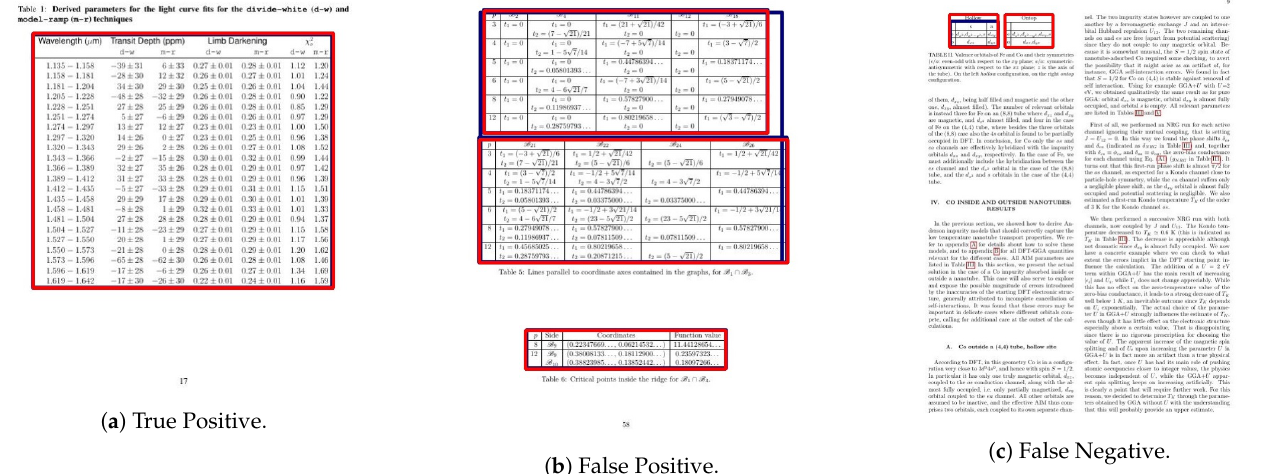
Figure 6. HybridTabNet results on TableBank Latex dataset. ( a – c ) True positive, False positive, and False negative results, respectively. The blue outline shows the predicted table, and the red outline highlights the ground truth